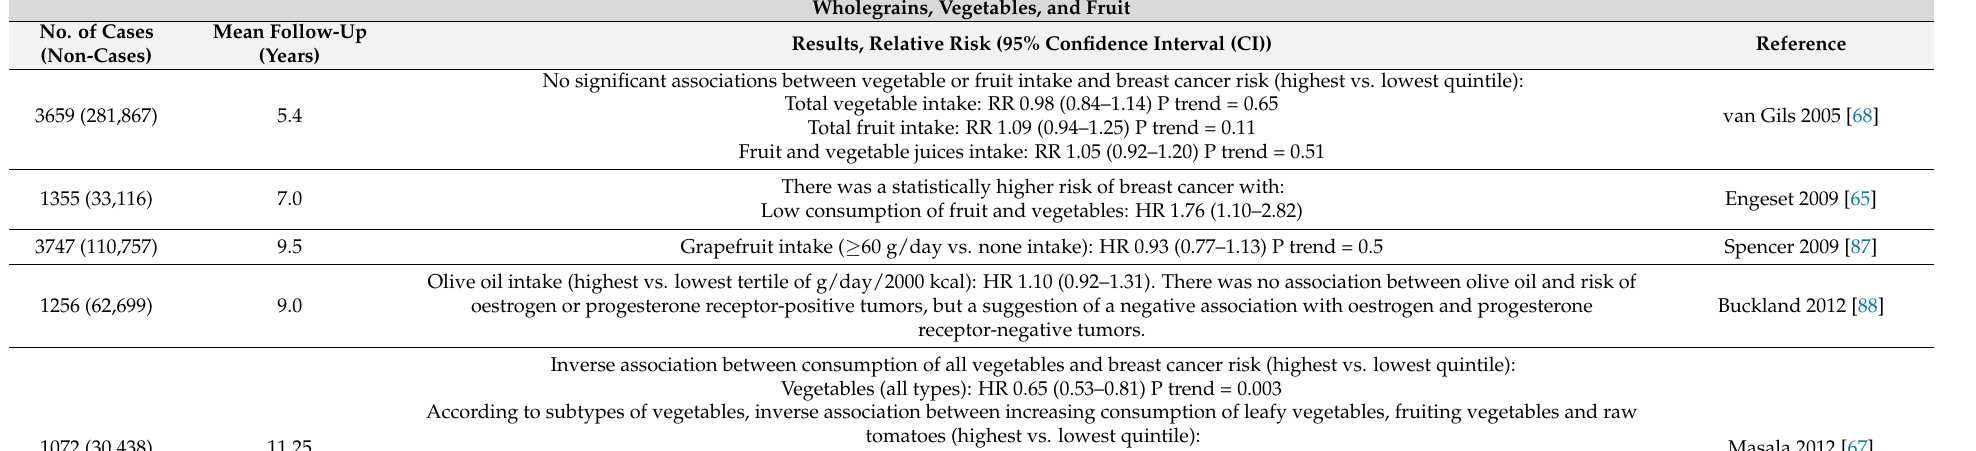
Breast cancer risk was inversely associated with intakes of total dietary fiber (highest vs. lowest quintile): HR 0.95 (0.89–1.01) P trend = 0.03, and fiber from vegetables: HR 0.90 (0.84–0.96) P trend = 0.01, but not with fiber from fruit, cereals, or legumes. For vegetable fiber, stronger associations were observed for oestrogen-receptor–negative and progesterone-receptor–negative (highest vs. lowest quintile): HR 0.74 (0.59–0.93) P trend = 0.01, than for oestrogen-receptor–positive and progesterone-receptor–positive tumors: HR 0.92 (0.81–1.03) P trend = 0.05 Vegetable intake was associated with a lower risk of breast cancer (highest vs. lowest quintile): HR 0.87 (0.80–0.94). Although the inverse association was most apparent for oestrogen and progesterone receptor–negative breast cancer (highest vs. lowest quintile): HR 0.74 (0.57–0.96) P trend = 0.03, and oestrogen and progesterone receptor–positive breast cancer: HR 0.91(0.79–1.05) P trend = 0.14. Fruit intake was not significantly associated with total and hormone receptor-defined breast cancer